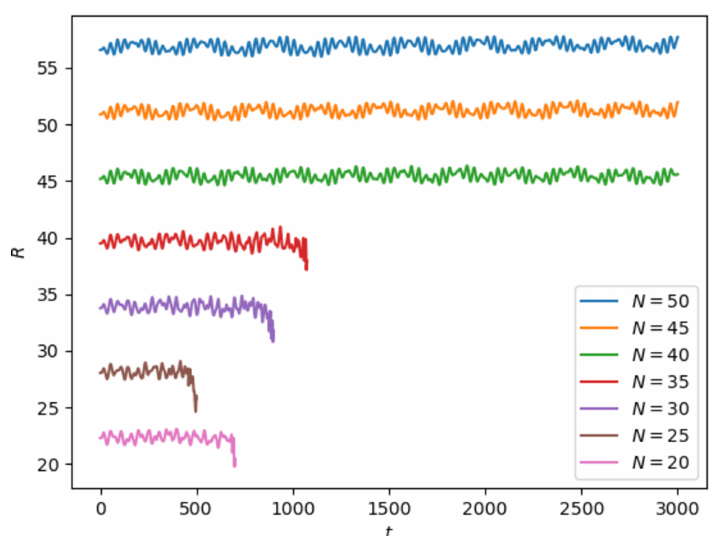
Figure 23 . The evolution of the position of the core of the string along y = z = 0 for vortons with different values of the winding number, N , in parameter set B, with the ratio of N to Q kept fixed, and using a fourth order stencil for the spatial derivatives — higher than the previous simulations. The N = 20 vorton is the same one shown in figure 22, although here it is excited with only the m = 4 mode with an amplitude of 0 . 1 . All the vortons in this plot are excited with the m = N/ 5 mode (so that the wavenumber m/R remains roughly constant) with an initial amplitude of 0 . 1 . Note that the bottom four plots have been cut off at roughly the point where the vortons are destroyed, while the top three survive until the end of the simulation at t = 3000